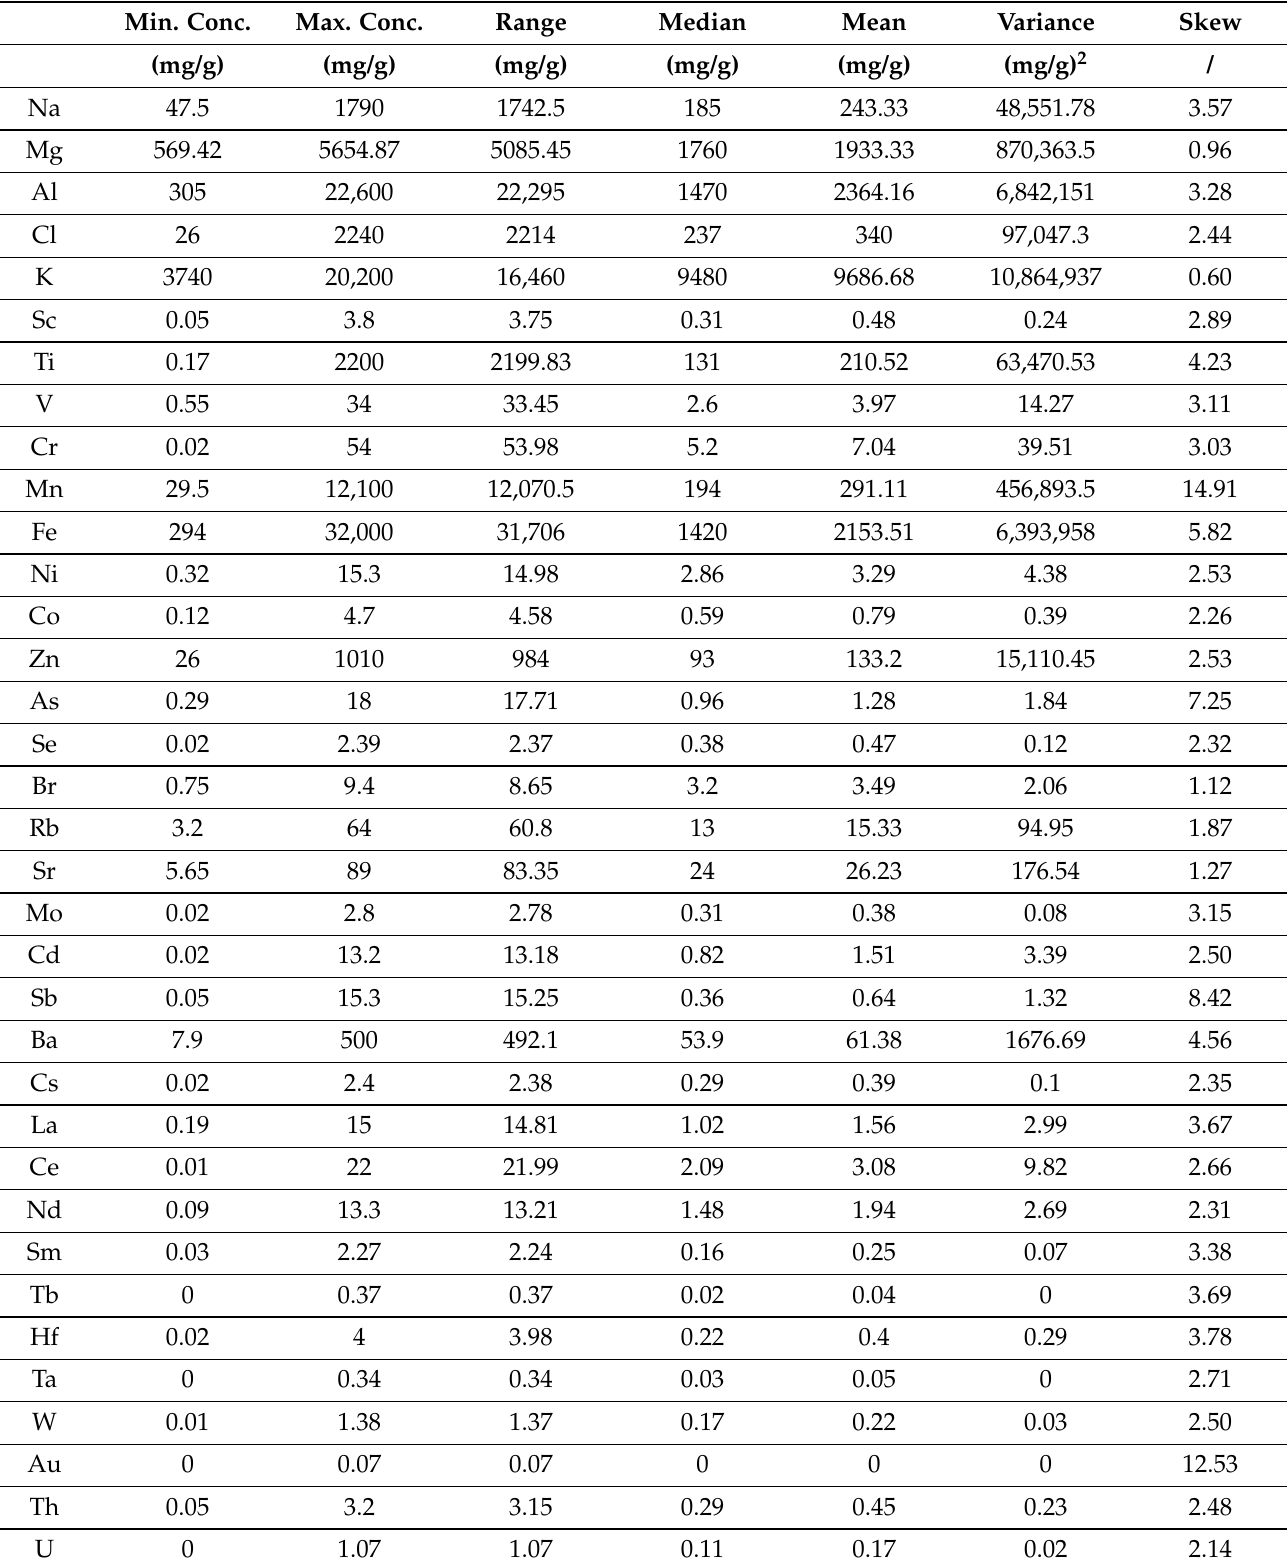
Table 3. Basic statistical characteristics of the INAA